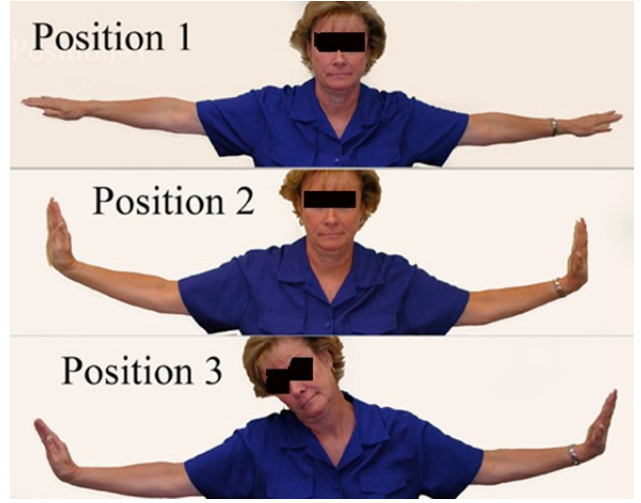
Figure 5. Upper Limb Tension Test (ULTT).